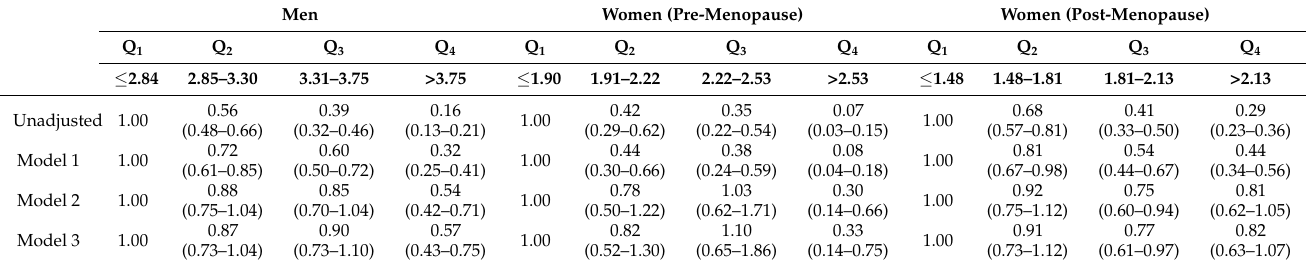
Model 1: adjusted for age; Model 2: adjusted for age, waist circumference, regular exercise, smoking status, and alcohol uptake; Model 3: adjusted for age, waist circumference, regular exercise, smoking status, alcohol uptake, total cholesterol, TG, AST, ALT, and systolic blood